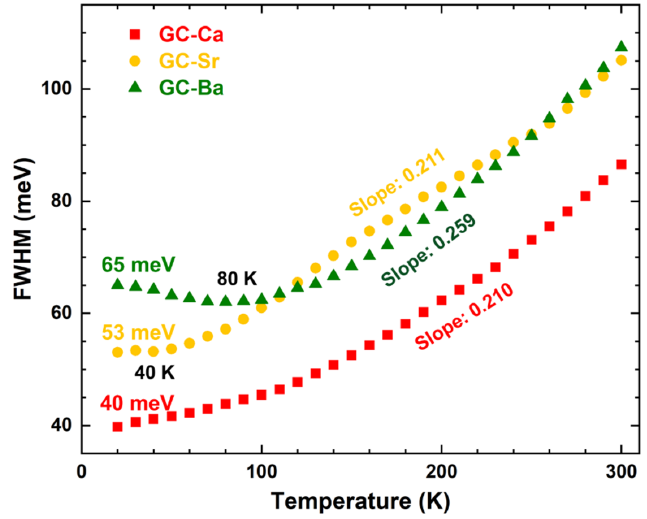
Figure 3. FWHM PL intensity of the GC ‐ Ca, GC ‐ Sr, and GC ‐ Ba as a function of temperature.